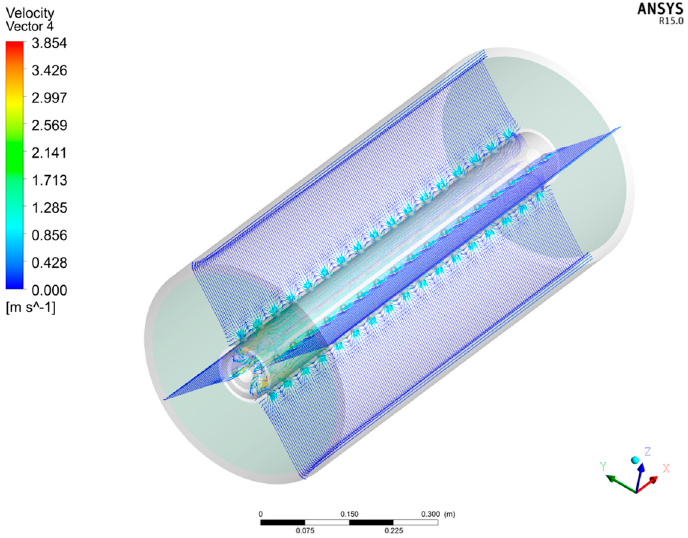
Figure 10. 3D vector field of shell side velocity in the HF bundle considering the detailed structure of module.